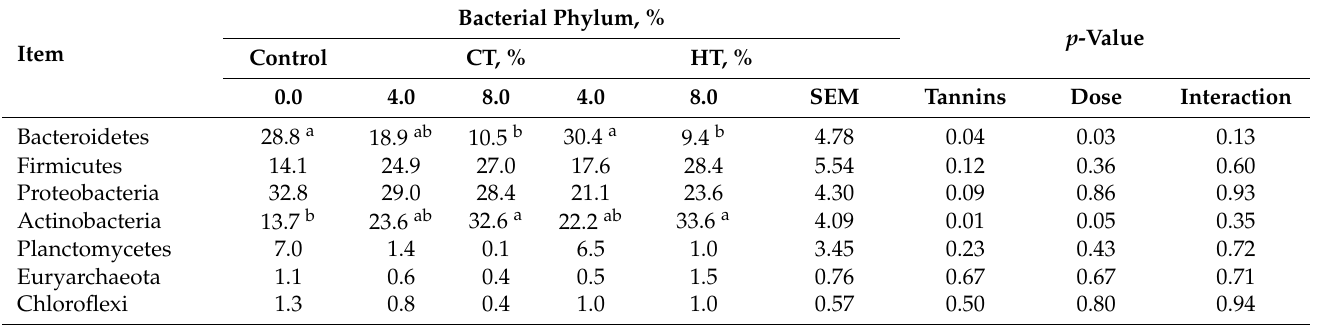
Table 2. Mean relative abundance values (%) of the most predominant bacterial phyla (> 1.0%) as a function of the addition of tannins with different dose levels of tannins in dairy cattle manure.